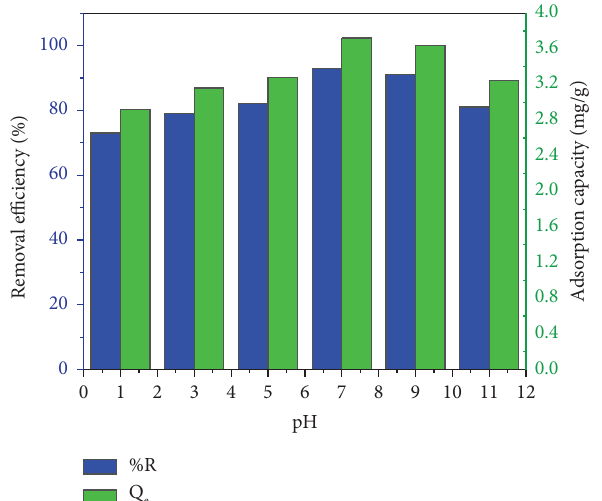
Figure 7: Efect of pH on fuoride ion % removal and equilibrium adsorption capacity (0.25 g adsorbent, 30min contact time, 10mg starting fuoride concentration, and 25 ° C).